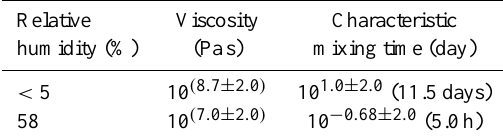
Table 2. Viscosities of α -pinene-derived secondary organic mate- rial at the lower and upper relative humidities of this study. Also shown are the characteristic mixing times for a diffusing species in a spherical SOM particle of 100nm. An effective radius of 1.5nm is used. See main text for further